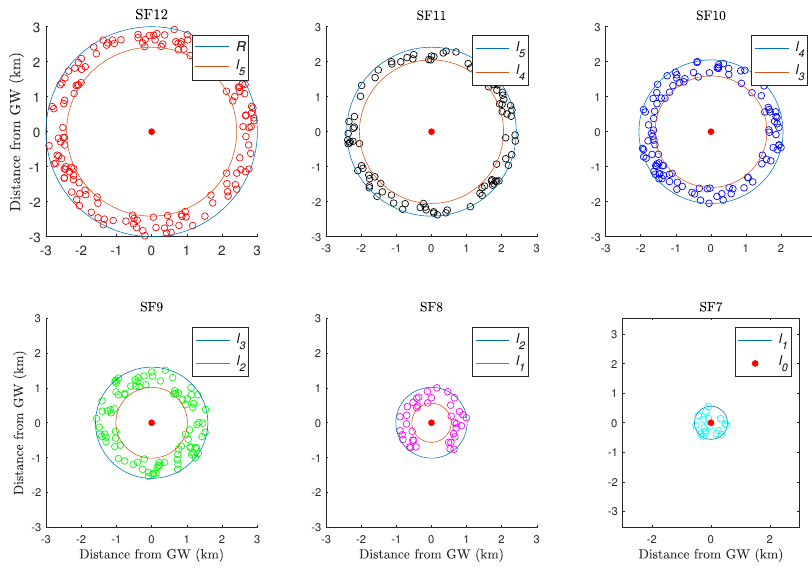
Figure 2. K-means iterations for SF allocation based on Fibonacci series and 500 nodes, where l i and l i + 1 are the inner and outer radii of i th annulus,